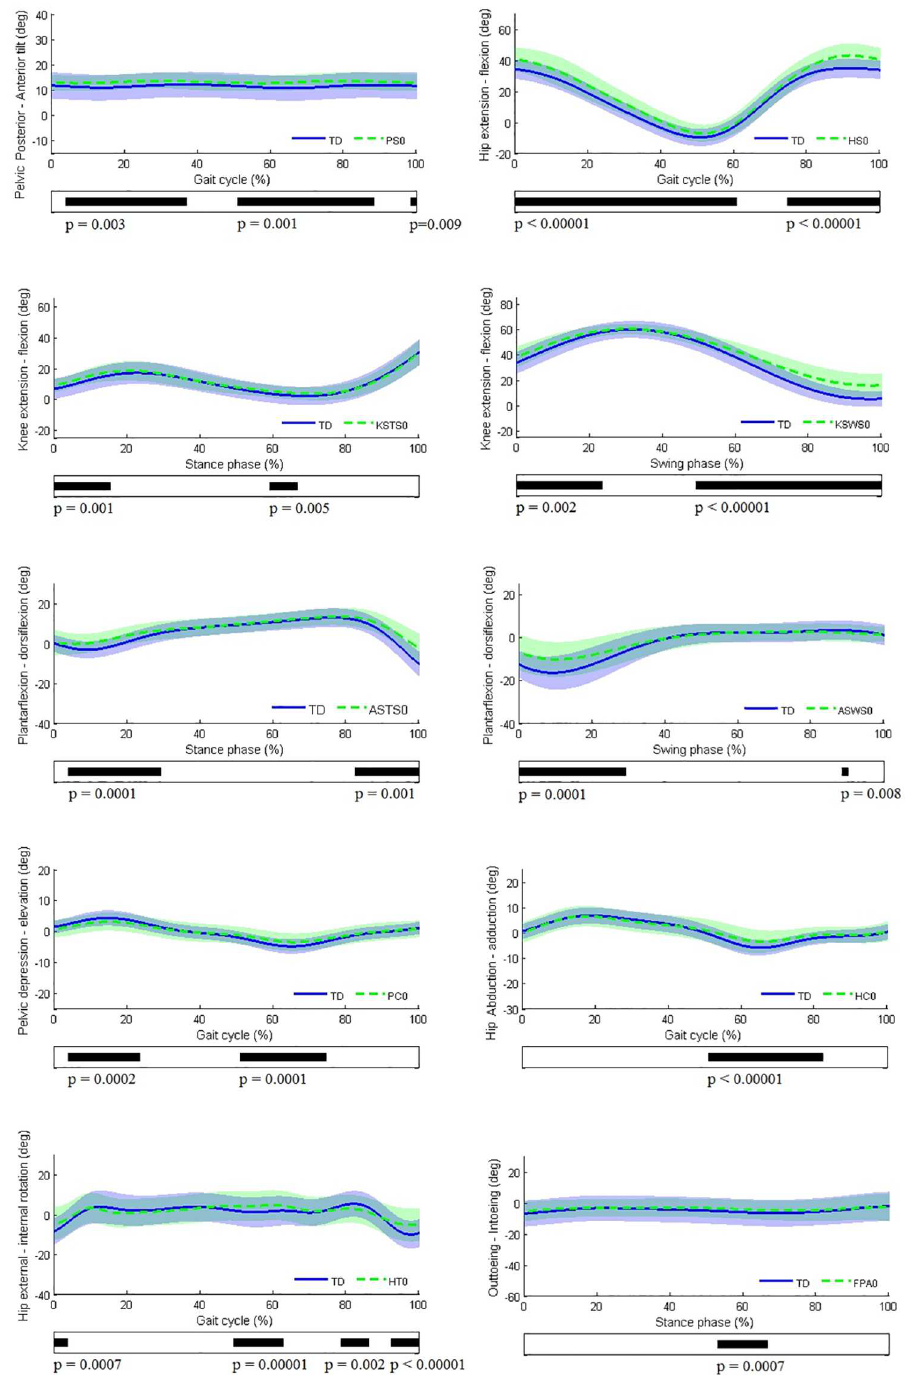
Fig 2. Each graph shows the mean kinematic angle of TD gait versus the pattern ‘no or minor gait deviations’ at the level of each joint, except for the pelvis in the transverseplane (no significant differences). Black bars indicategait phases during which the SPM{t} statistic exceededthe critical threshold.